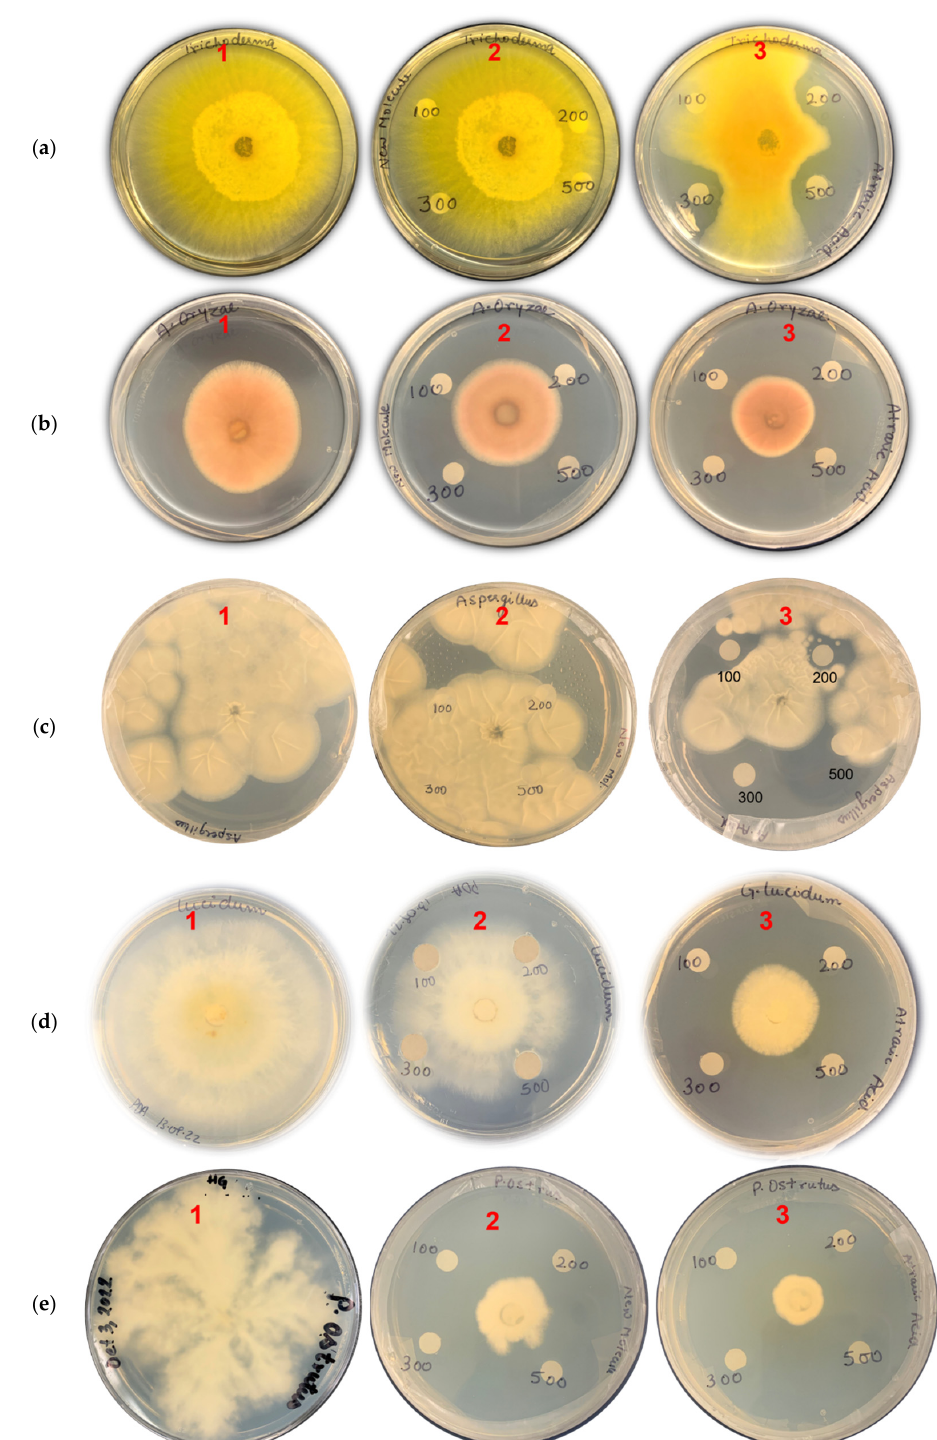
Figure 6. The antifungal activity of compounds 1 and 2 at different concentrations (100 μ g/mL, 200 μ g/mL, 300 μ g/mL, and 500 μ g/mL) on the mycelium growth of different fungal strains: ( a ) Trichoderma citrinoviride , ( b ) Aspergillus oryzae , ( c ) Aspergillus spp ., ( d ) Ganoderma lucidum , ( e ) Pleurotus ostreatus ; (1) control; (2) compound 1 ; (3) compound 2 , Magnification is at 1× ( no magnification ).